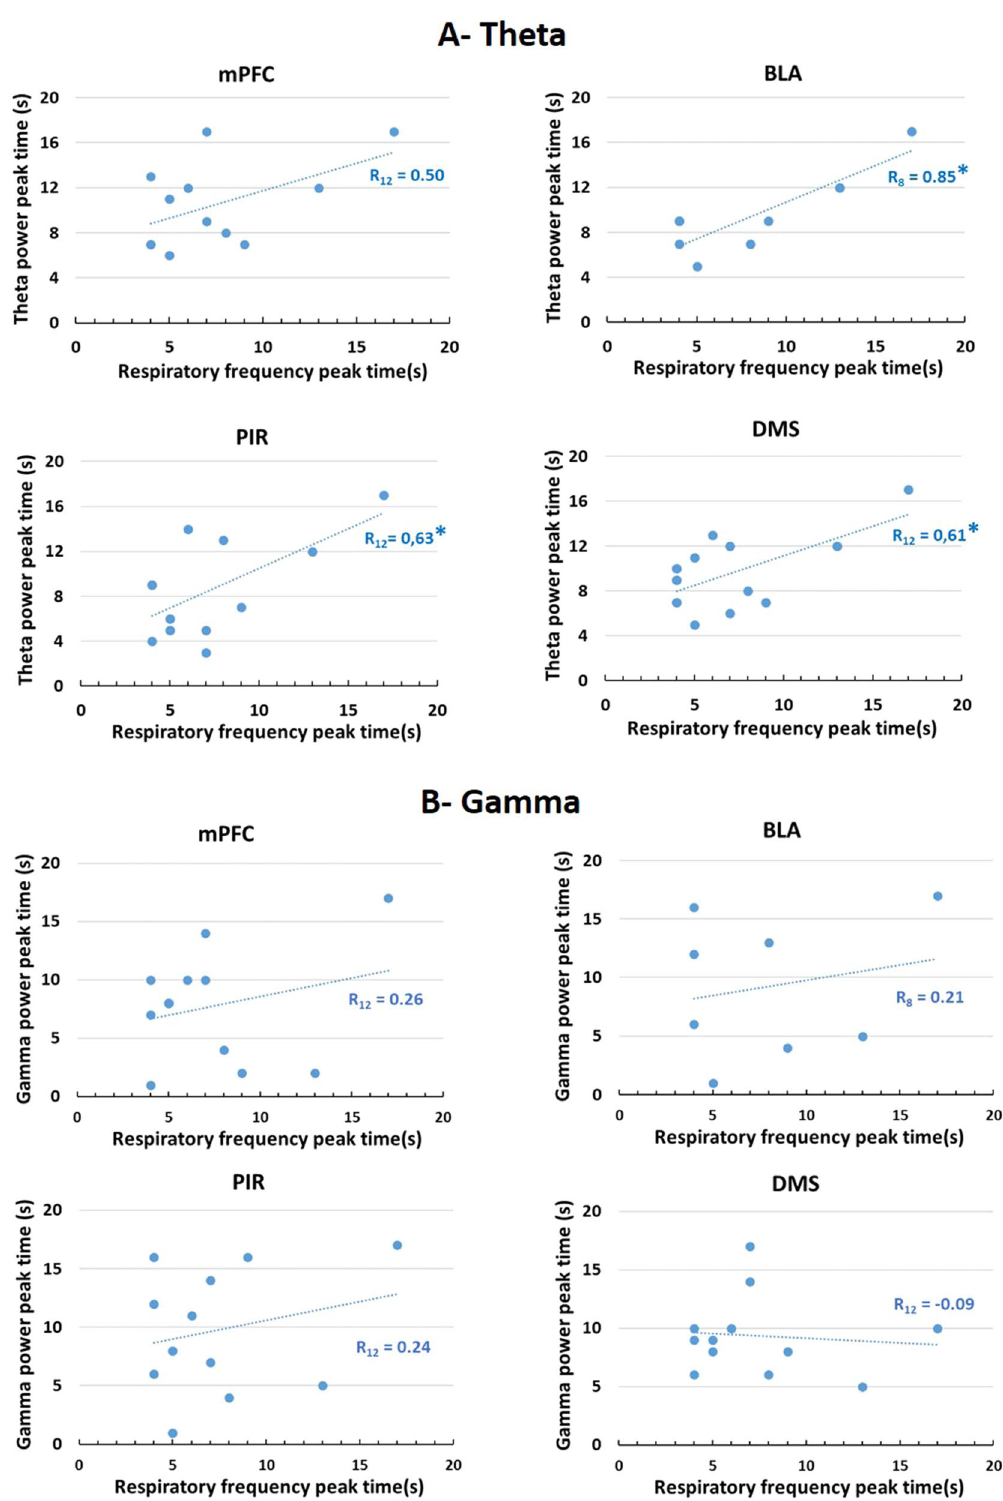
Figure 6. ( A ) Correlation between the time of the peak respiratory frequency and the time of the peak theta activity power in the four recording sites during the Conditioning session. mPFC medial prefrontal cortex, BLA basolateral amygdala, PIR olfactory piriform cortex, DMS dorso-medial striatum. *Significant correlation index, p ≤ 0.05. ( B ) Correlation between the time of the peak respiratory frequency and the time of the peak gamma activity power in the four recording sites during the Conditioning